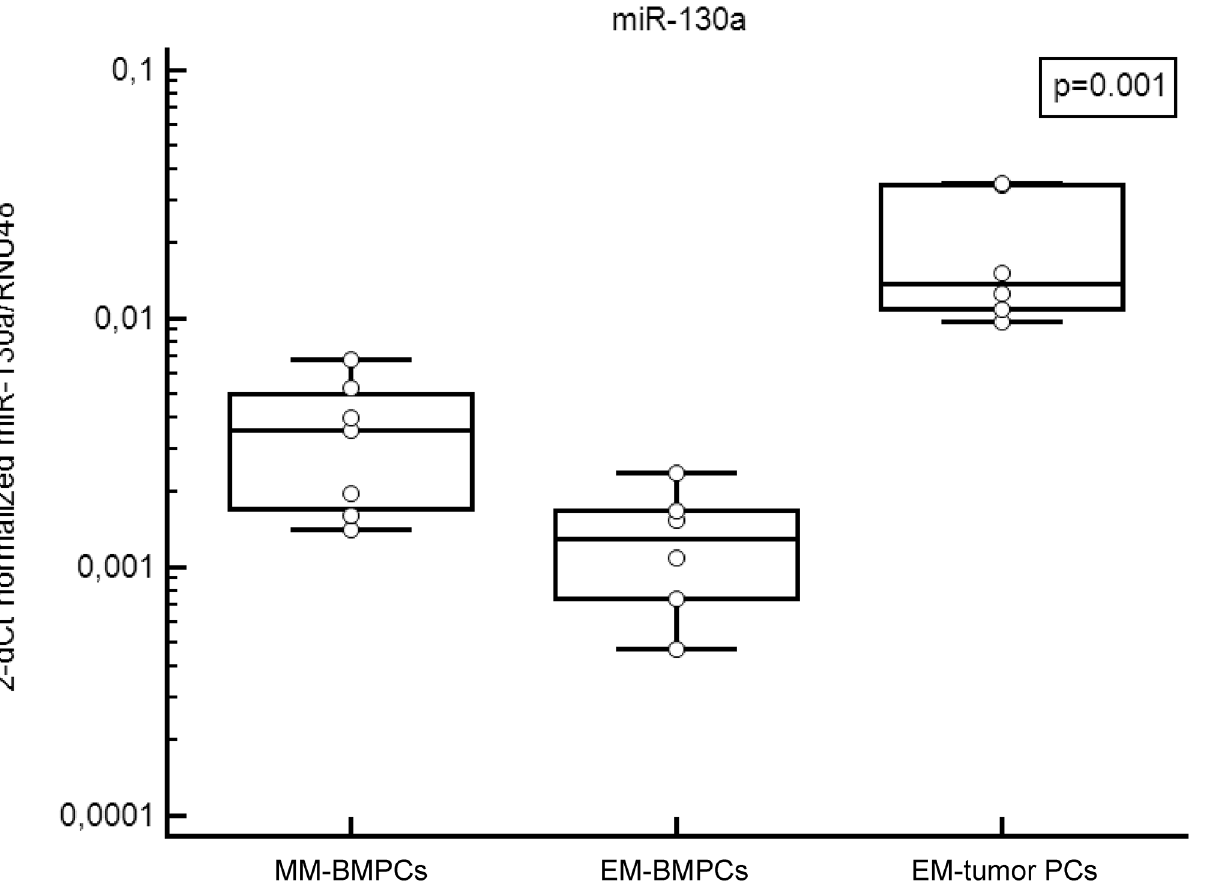
Fig 3. Level of miR-130a in CD138+ bone marrow plasma cells and tumor plasma cells. Level of miR-130a normalized to RNU48 in bone marrow plasma cells (BMPCs) and tumor plasma cells of multiple myeloma (MM) patients and patients with extramedullary disease (EM).